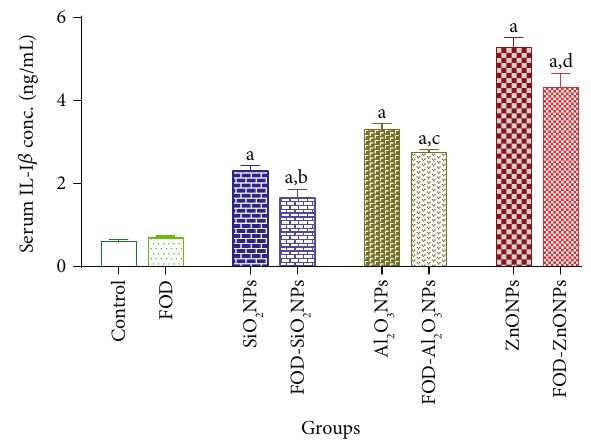
Figure 3: The e ff ects of fi g with olive oil and date-palm fruit extracts (FOD) on the serum interleukin-I β (IL-I β ) in rats treated with di ff erent nanoparticles (NPs) for 75 days. a p < 0 : 05 versus control group; b p < 0 : 05 versus SiO O NPs; d p < 0 : 05 versus ZnONPs. N.B: the antioxidants Al 2 3 (FOD) treatments were used for 2 weeks before and during the administration of the nanoparticles.